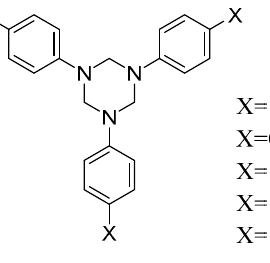
Figure 1. Structures and names of compounds 1a – e as corrosion inhibitors [26].